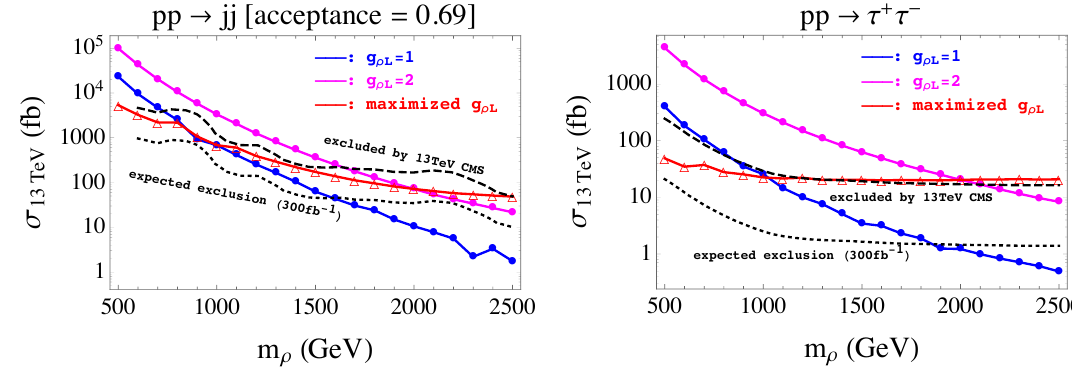
Figure 7 . Naive constraints on (cid:27) ( pp ! jj ) [left panel] and (cid:27) ( pp ! (cid:28) (cid:22) (cid:28) ) [right panel] in (cid:18) D = (cid:18) L = 0, where the CMS experimental results are from refs. [128, 129]. For the dijet resonance, we adopt the calculated value of acceptance A = 0 : 69 being di(cid:11)erent from the isotropic decays ( A (cid:25) 0 : 6) [128]. For the red curves showing ‘maximized g (cid:26)L ’ being consistent with the requisites from (cid:13)avor issues in eq. (4.33), the value of g (cid:26)L is tuned as j g (cid:26)L j = 1 : 0 (cid:2) ( m (cid:26) = 1 TeV). If g (cid:26)L is greater than the tuned value (in each of m (cid:26) ), we cannot address the (cid:13)avor issues in the present model correctly. The regions above the black dashed (black dotted) lines are excluded (expected to be excluded after a 300 fb (cid:0) 1 integrated luminosity accumulation) at 95%